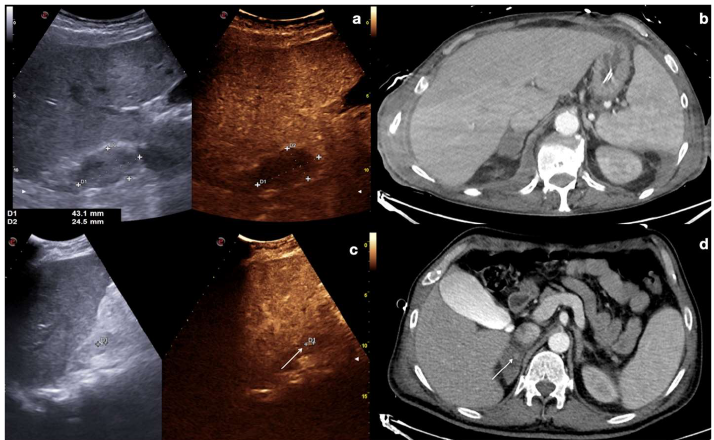
Figure 11. Adrenal gland hematoma. CEUS ( a ) and contrast-enhanced CT ( b ) of a 44−year-old male patient after a motor vehicle accident, showing right adrenal gland hematoma with no vascular complication. CEUS ( c ) and contrast-enhanced CT ( d ) follow up of a 36-year-old male patient on day 3 after a car accident; a pseudo-aneurysm within the right adrenal gland hematoma is visible (white arrows).